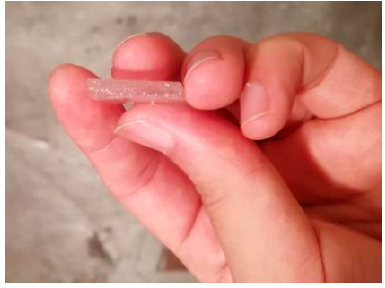
Figure 6. Icing thickness.